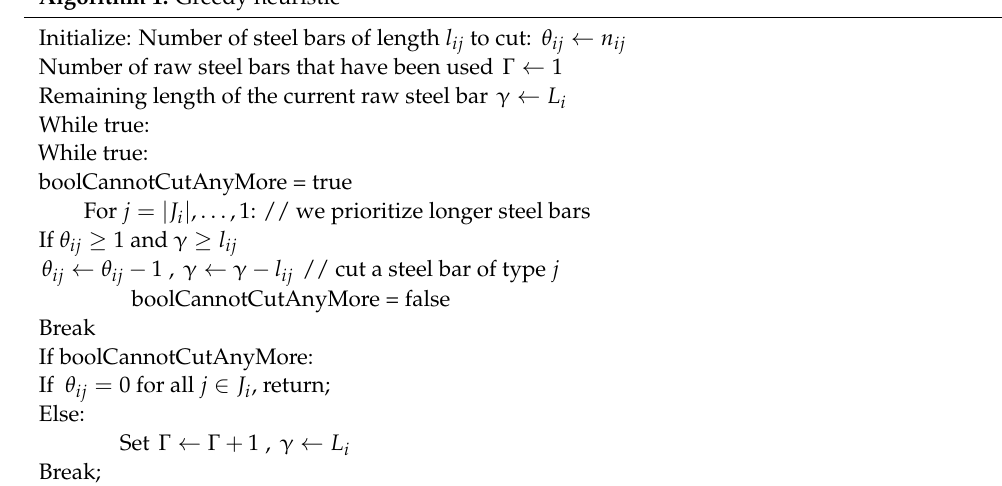
Algorithm 1: Greedy heuristic